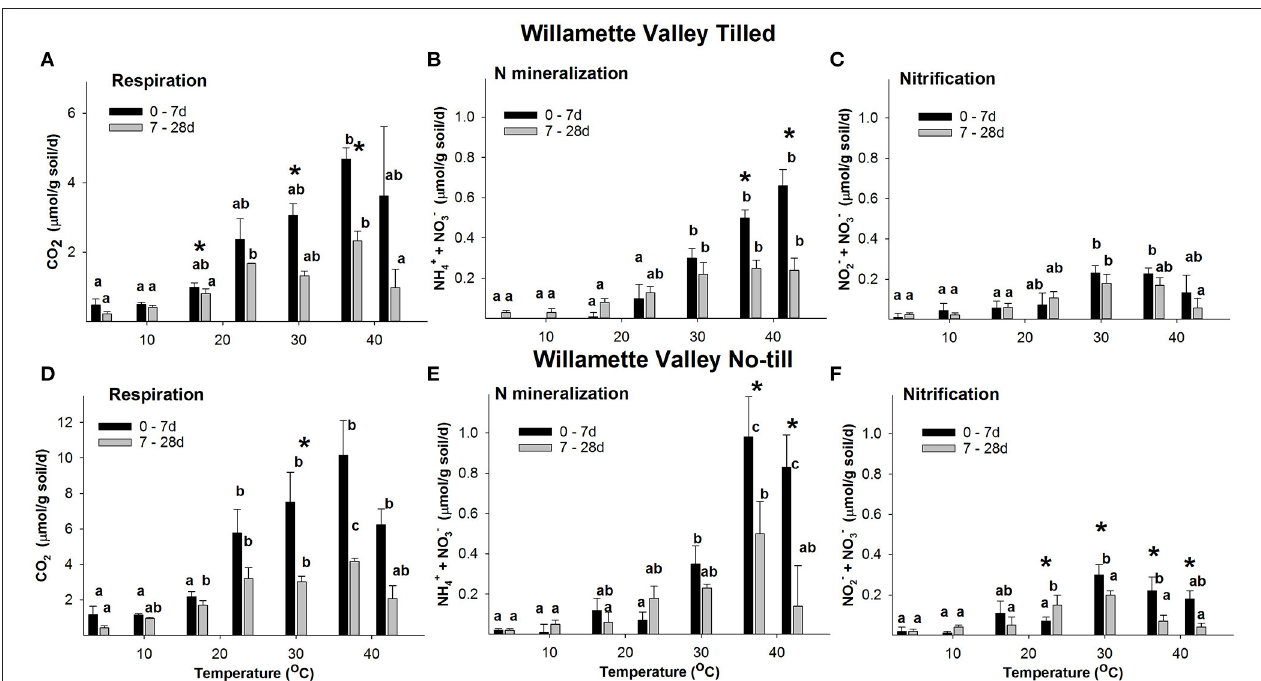
FIGURE 2 | The rate response of respiration (A,D) , N mineralization (B,E) , and nitrification (C,F) in Willamette Valley soils across temperatures. Figure data are the average of three field replicates and the error bars represent the standard deviation. Lower case letters indicate where RM ANOVA analysis found significant differences in rates over the temperatures within a time period. Asterisks indicate where rates at 0–7 d differ significantly from 7 to 28 d ( p ≤ 0.05).